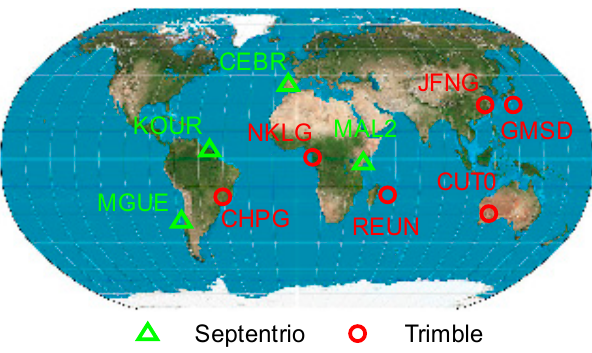
Figure 2. Distribution of the selected MGEX stations used in this study.